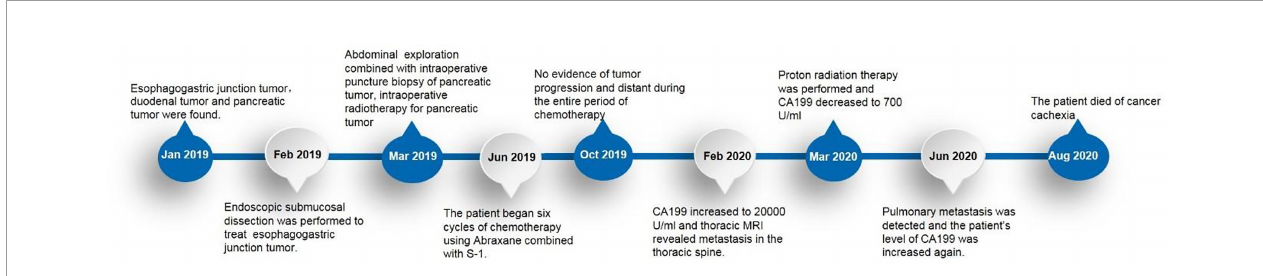
FIGURE 4 | Timeline of MPC progression in our female